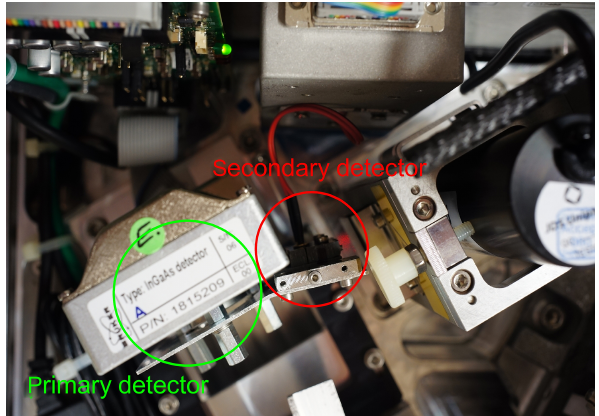
Figure 4. This image provides a top view of the detector units. The primary detector remains in its standard detector box; the support- ing structure for the secondary field stop is mounted on the box of the primary detector. The secondary detector and the Ge filter are accommodated in a separate holder, which can be adjusted laterally with respect to the field